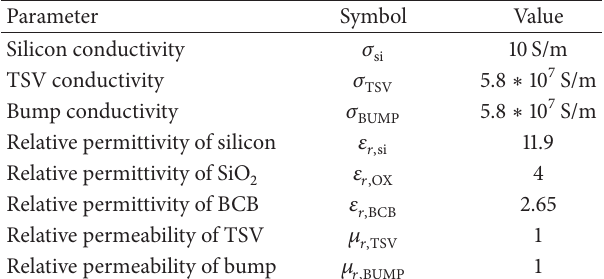
Table 2: Material property of proposed model. Table 3: RLC analytical formula of different transmission lines [12] see Figure